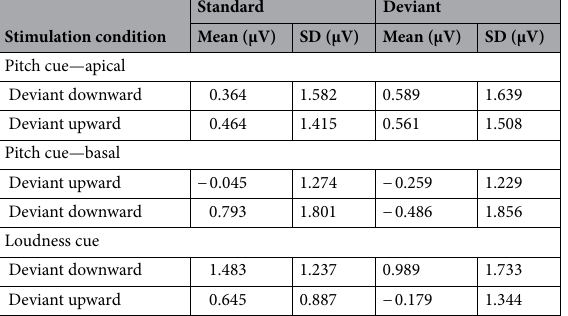
Table 3. Mean amplitudes of the waveforms following standard and deviant responses in the latency range of the expected